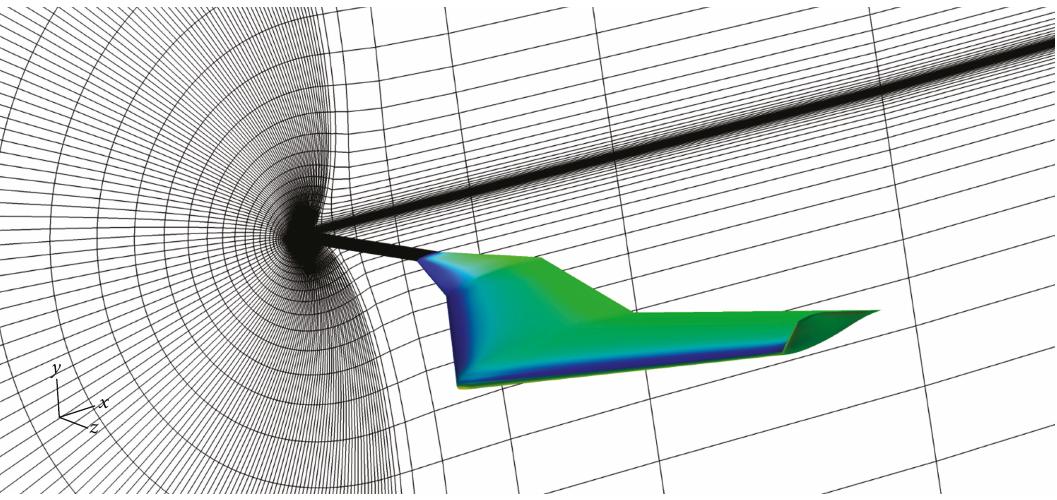
Figure 9: The 3D wing with folding tips constructed from the BGK